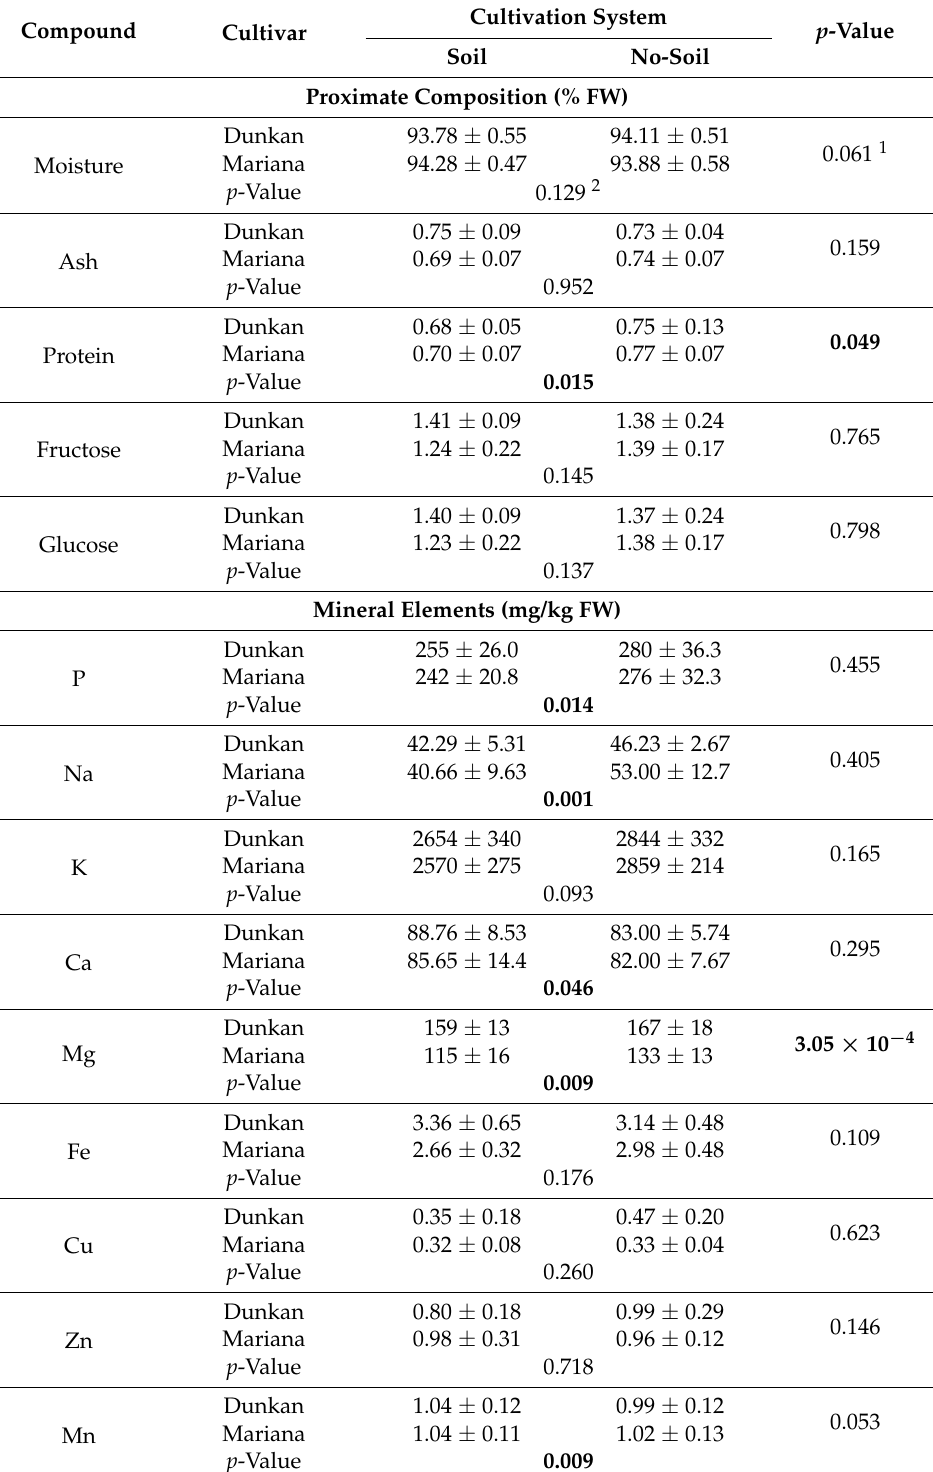
Table 1. Proximate and mineral elements composition (mean ± standard deviation, data expressed in fresh weight, FW) of tomato samples grouped according to cultivar and cultivation